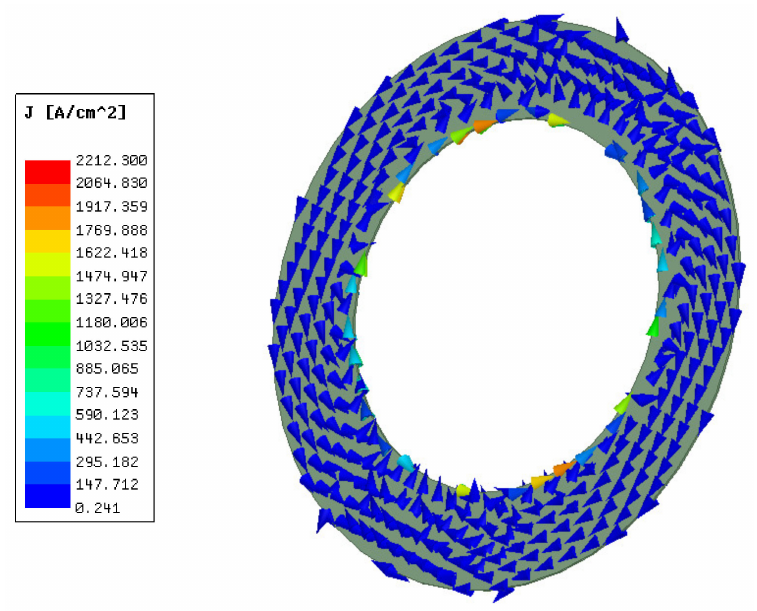
Figure 4. Distribution of the current density J in the copper screen of the synchronous generator.